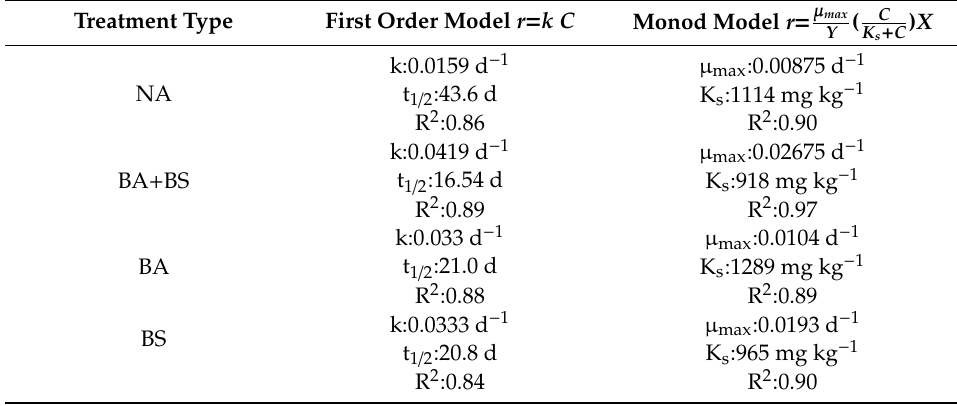
Table 3. Calculated reaction rate factors for the first-order and the Monod models. Treatment